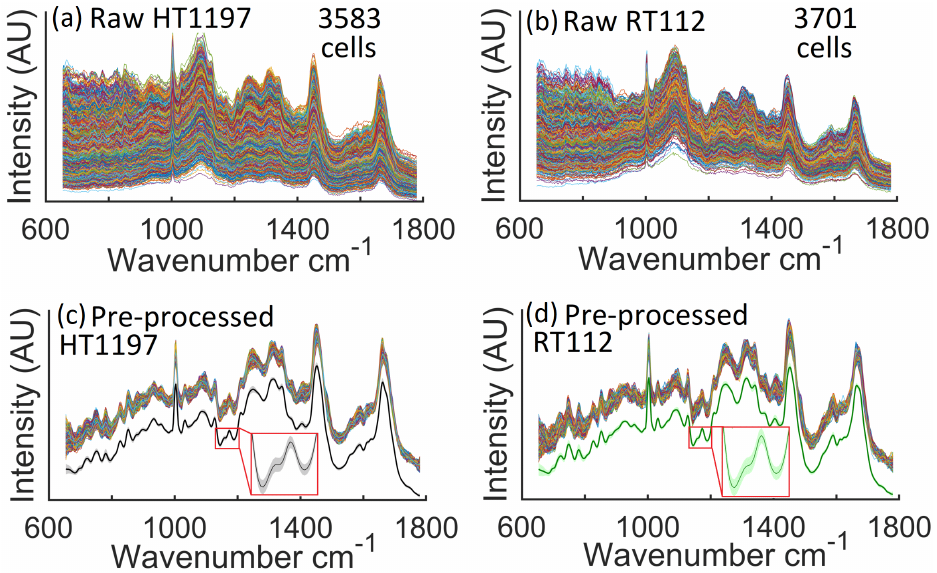
Figure 5. Raw and processed data from high- and low-grade bladder cancer cell lines. Raw spectra recorded using the proposed automated Raman micro-spectrometer, following cosmic ray removal; ( a ) 3583 spectra taken from individual HT1197 cell nuclei; and ( b ) 3701 spectra taken from individual RT112 cell nuclei; ( c ) the pre-processed HT1197 dataset, below which the mean spectrum is shown with a black line around which the standard deviation of the dataset is shown using a shaded grey colour; ( d ) the pre-processed RT112 dataset, below which the mean spectrum is shown with a green line around which the standard deviation of the dataset is shown using a shaded light green colour.